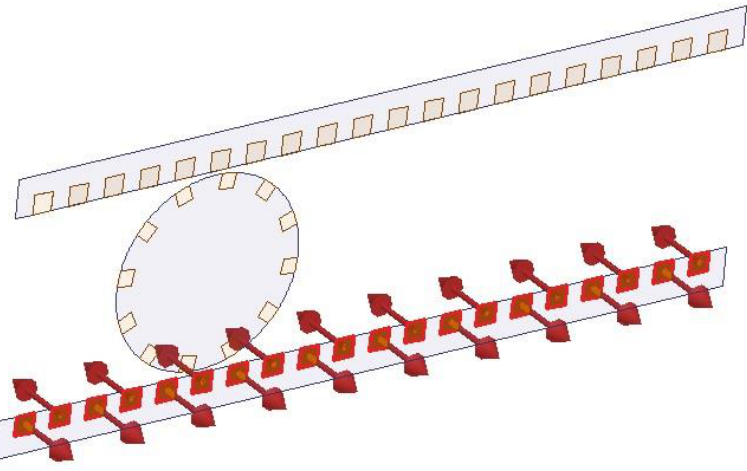
Figure 14. Configuration of the current direction in the bottom coil.